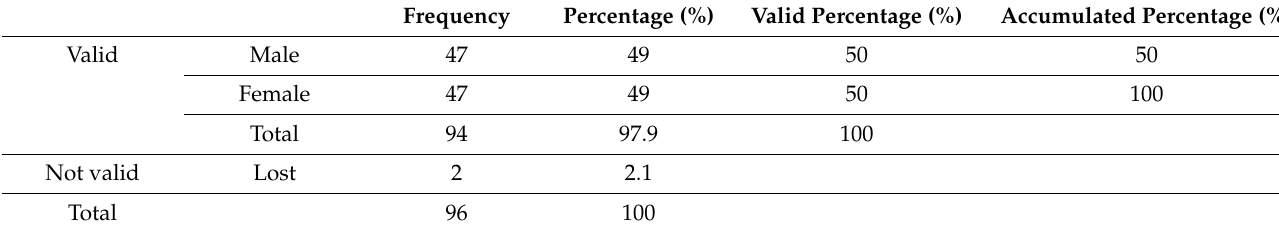
Table 4. Specify the number of patients according to gender.